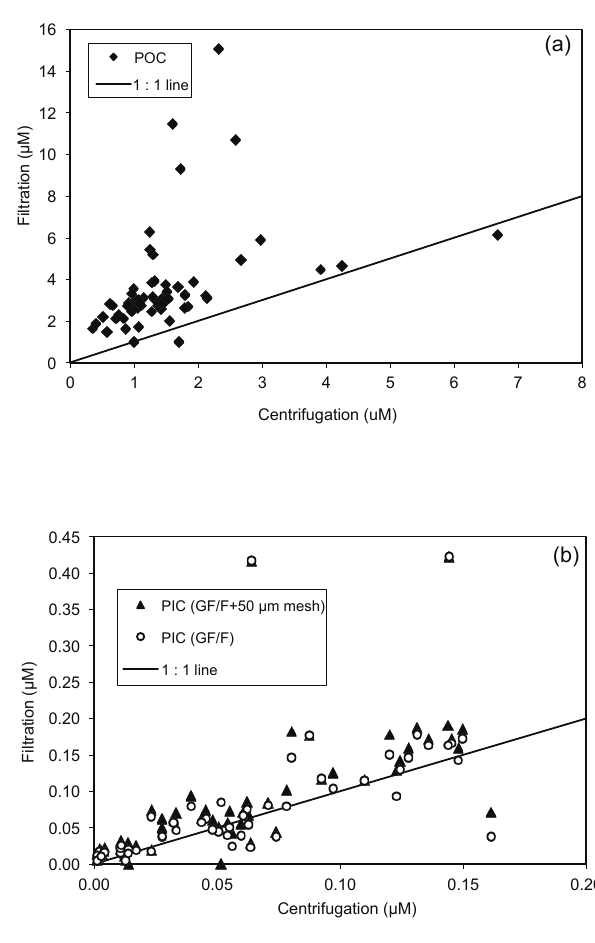
Figure 2. Comparison of centrifugation versus filtration size- fraction results for voyage leg 1: (a) centrifugation total POC ver- sus filtration POC (0.8–50µm fraction); (b) centrifugation total PIC versus filtration PIC01 (0.8–50µm) and PIC50 (50–1000µm) frac-